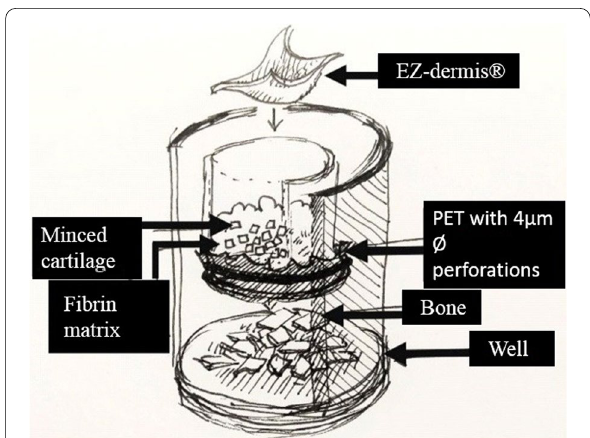
Fig. 1 Microfracture 3D – model used in our experimental setup in vitro: EZ Derm ® – porcine epidermis. Minced cartilage. Fibrin matrix – in some groups it has been replaced with chitosan‑based matrix. PET membrane with 4 µm pores and perforated with BD Microlance ®